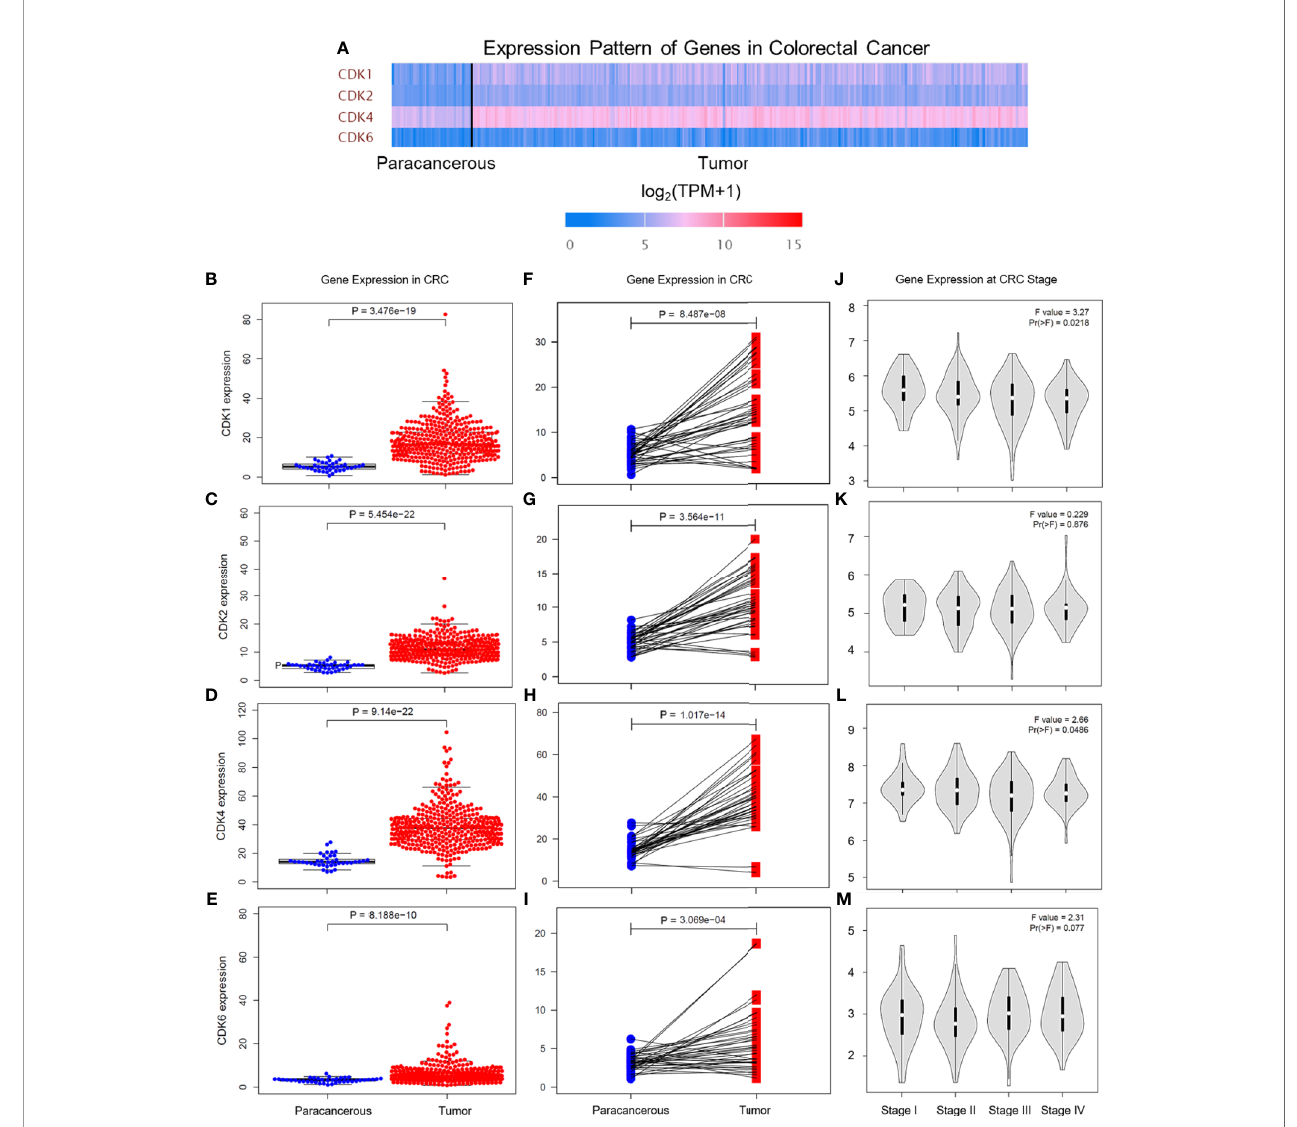
FIGURE 1 | Gene expression levels of CDKs in CRC based on TCGA database. (A) Gene expression levels of CDK1, CDK2, CDK4, and CDK6 in paracancerous tissue and CRC tissue. TPM means transcripts per kilobase million. (B ‒ E) Gene expression levels of CDK1 (B) , CDK2 (C) , CDK4 (D) , and CDK6 (E) in paracancerous tissue (n = 39) and CRC tissue (n = 398) of CRC. (F ‒ I) Gene expression levels of CDK1 (F) , CDK2 (G) , CDK4 (H) , and CDK6 (I) in paracancerous tissue and CRC tissue from each patient. (J ‒ M) Gene expression levels of CDK1 (J) , CDK2 (K) , CDK4 (L) , and CDK6 (M) in different CRC